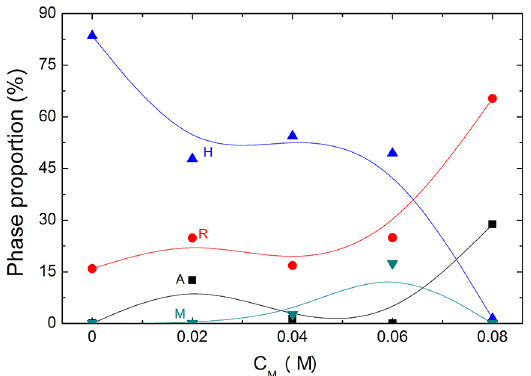
. The letters stand M